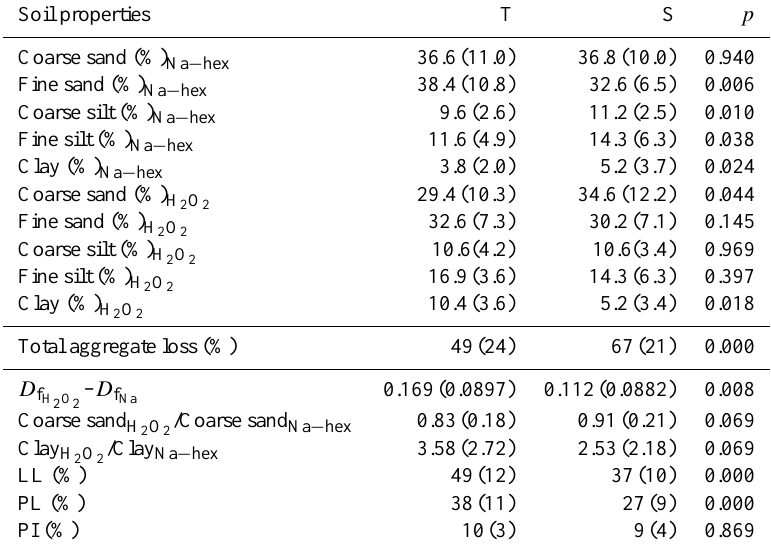
Table 2. Considered physical properties for topsoil (T) and subsoil (S) samples. Standard dev. in brackets ( n = 41), significance levels expressed by p-values (Na-hex indicates soil texture without, H 2 O 2 with soil organic matter